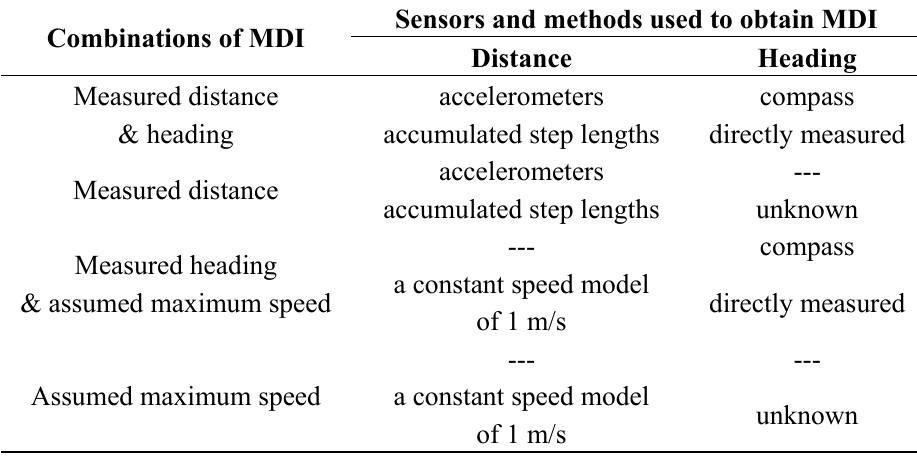
Table 1. Different scenarios using various combinations of